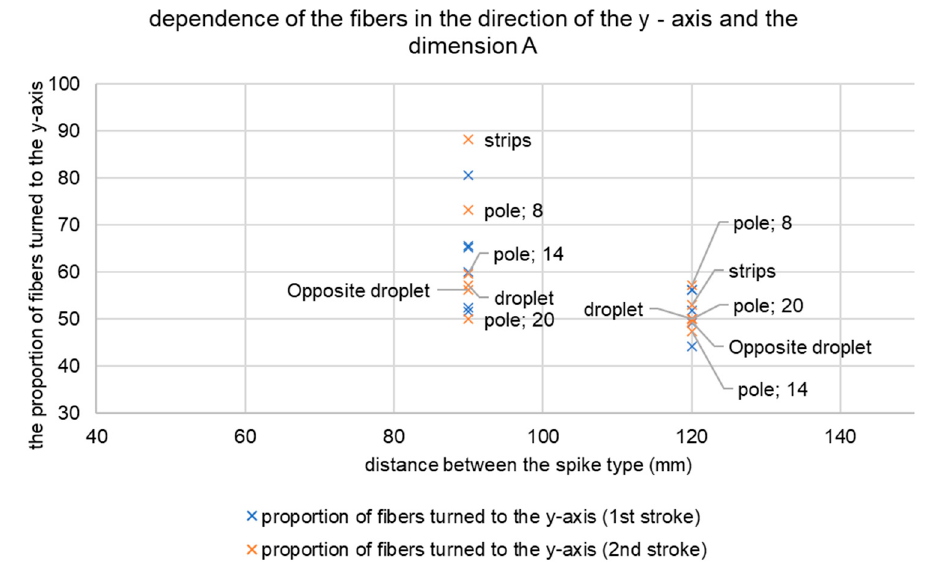
Figure 12. Dependence of the fibres in the direction of the y-axis and the dimension A.